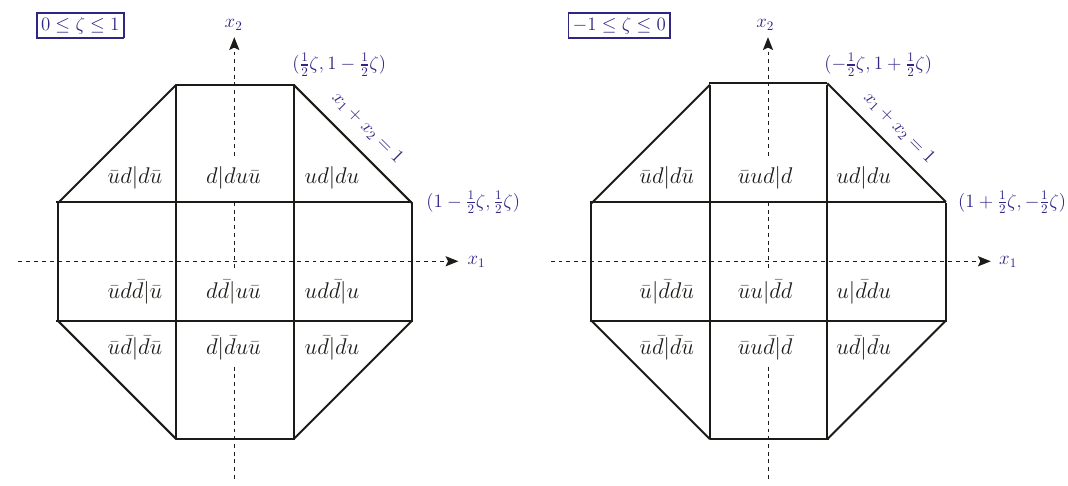
Figure 2 . Support regions of F ud ( x i , ζ, y ) w.r.t. the arguments x i and ζ . This is shown for positive (left) and negative (right) skewness parameter ζ . For each sub-region we indicate the (anti-)quark content of the wave function and its complex conjugate. The notation u | ¯ ddu means that we have a ¯ u -quark in the proton wave function and ddu in its complex